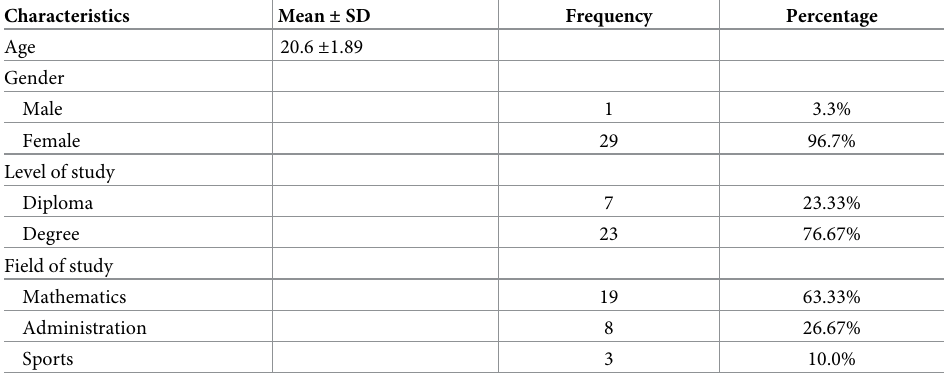
Table 2. Demographic background of the students (n =